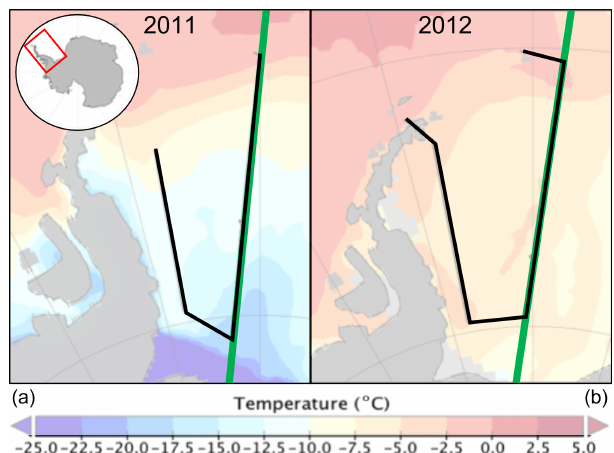
Figure 1. Maps of the Operation IceBridge 13 October 2011 (a) and 7 November 2012 (b) Sea Ice Endurance campaign flight paths (in black) along with the contemporaneous CryoSat-2 ground track (in green). Flight paths are overlaid on hourly average sea ice surface temperatures from MERRA-2 at the midpoint time of the IceBridge flight (MERRA-2 data from GMAO, 2015).